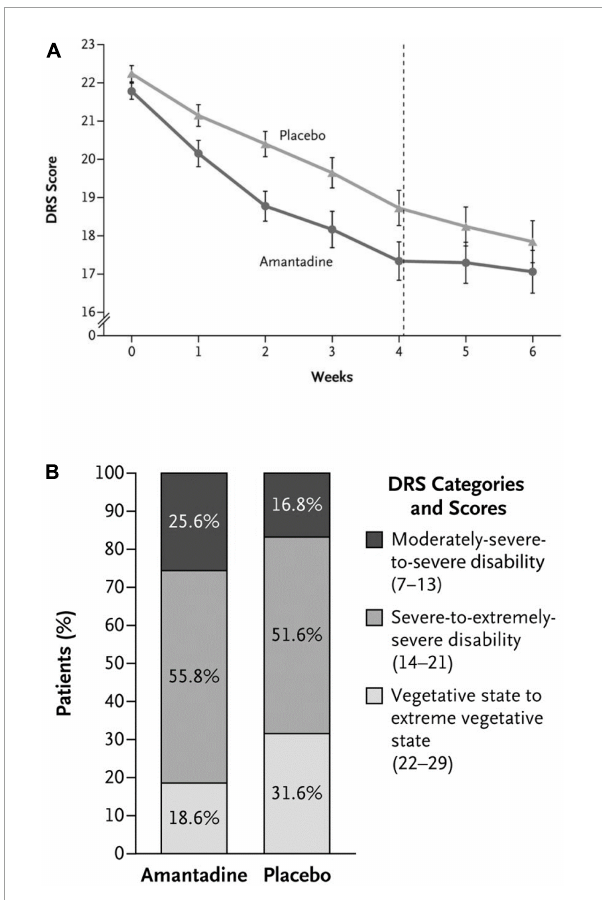
FIGURE4 (A) Rate of functional recovery (DRS score) as a function of duration of treatment with amantadine compared to placebo in patients with severe TBI. DRS scores were improved significantly more rapidly following amantadine during the 4 week treatment period compared to placebo. On weeks 5 and 6 (washout interval), recovery rates in the amantadine group were significantly slower. Error bars indicate mean values ± SE. (B) Effects of amantadine treatment compared to placebo as a function of the category of functional disability (DRS score). After 4 weeks of treatment, the proportion of patients in a vegetative-to-extreme vegetative